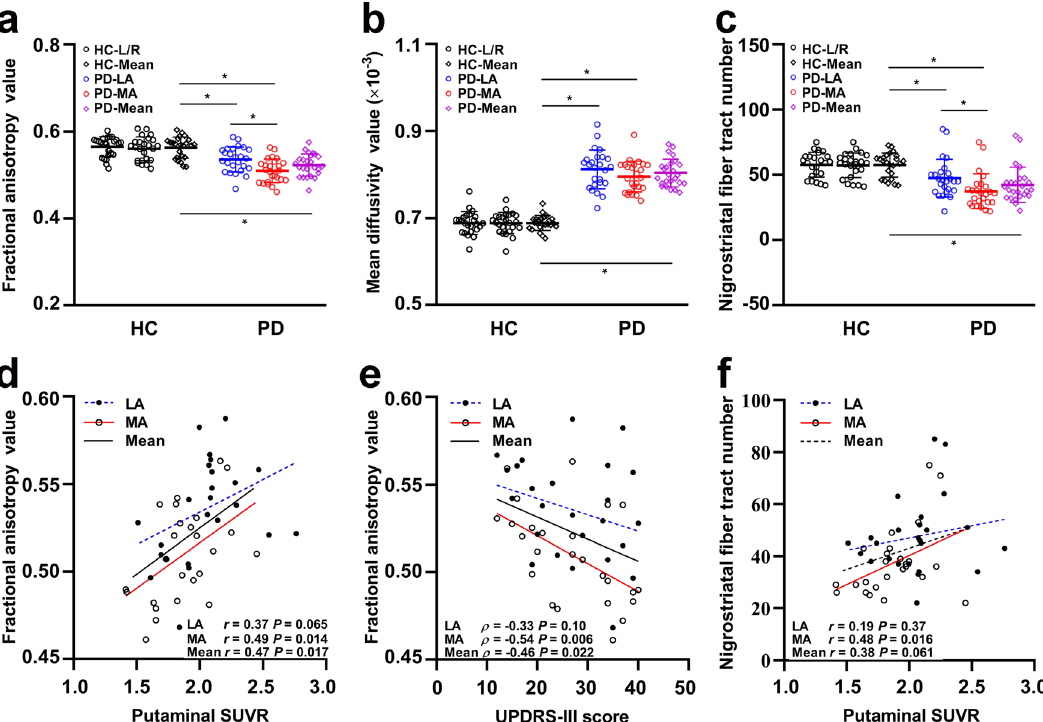
Fig. 4 Scatter plots of group differences in deterministic tractography, and correlations for PD subjects. Group differences of bilateral FA ( a ), MD ( b ), and TN ( c ) in HC subjects and PD patients, separately for MA and LA side of symptom onset in PD patients. d Correlation between the corresponded SUVR of putamen UPDRS-III ( X -axis) and the FA values ( Y -axis). e Correlation between the scores of UPDRS-III ( X -axis) and the FA values ( Y -axis). f Correlation between the TN values ( X -axis) and the corresponded SUVR of putamen ( Y -axis). * indicates signi fi cant difference ( P < 0.05) between groups. Solid line shows signi fi cant correlation ( P < 0.05). Dotted line indicates none signi fi cant correlation ( P > 0.05). Abbreviations: FA